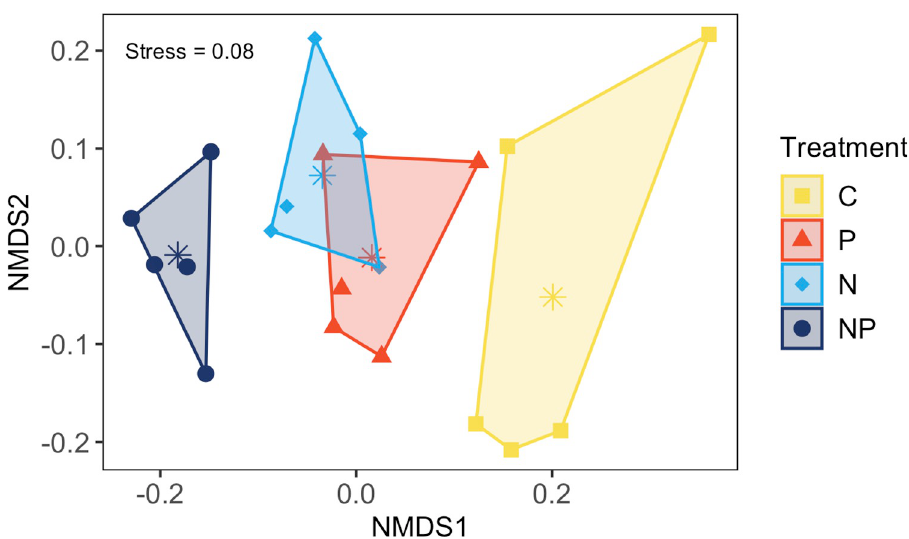
Fig 3. Non-metric multidimensional scaling ordination of species composition across nutrient enrichment treatments. Non-metric multidimensional scaling (NMDS) ordination of species composition grouped into convex hulls by nutrient treatment. Points represent within treatment replicates with stars indicating centroids of each treatment group. Centroids can be viewed as a representation of mean community composition. Colors and symbols are matched to nutrient treatment (C = control, P = phosphorus, N = nitrogen, NP = nitrogen + phosphorus).